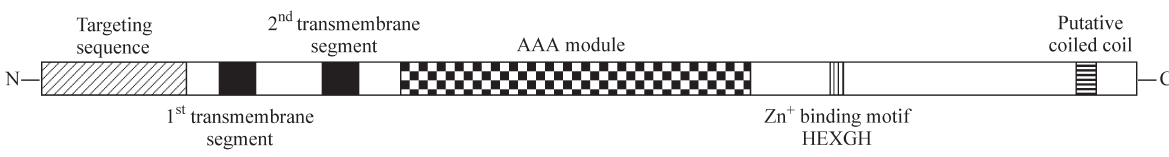
Figure 1 - Diagram of a typical eukaryotic AAA metalloprotease. The AAA module encompasses the Walker A and B groups and the second region of homology